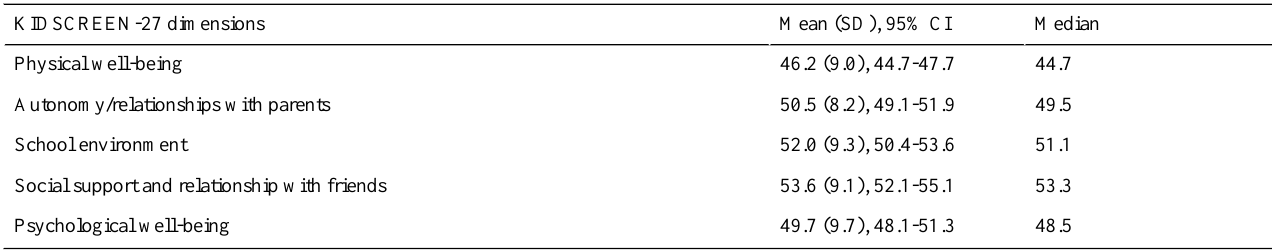
Table 3. Distribution of KIDSCREEN-27 dimensions.